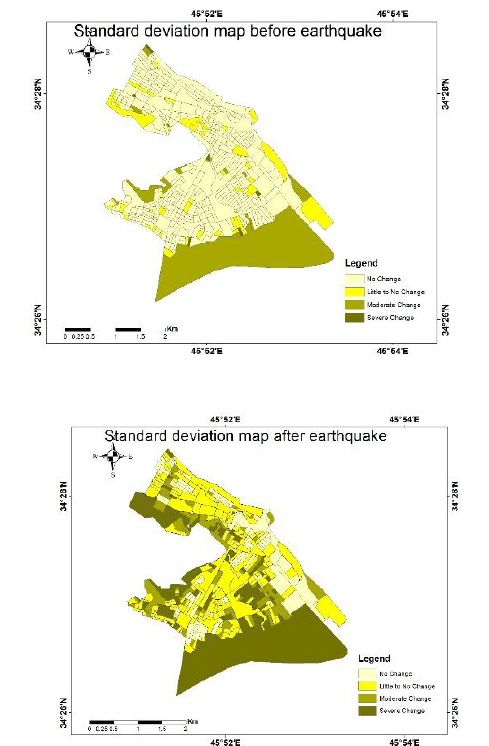
Figure 4: Standard deviation maps for Sarpol-e-Zahab before and after the